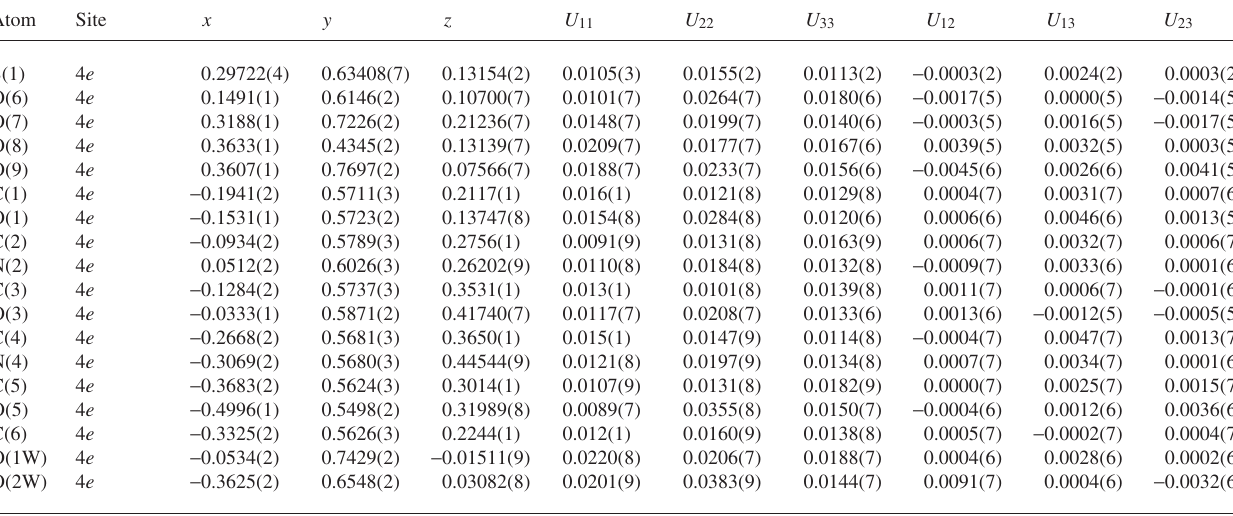
Table 3. Atomic coordinates and displacement parameters (in Å 2 )